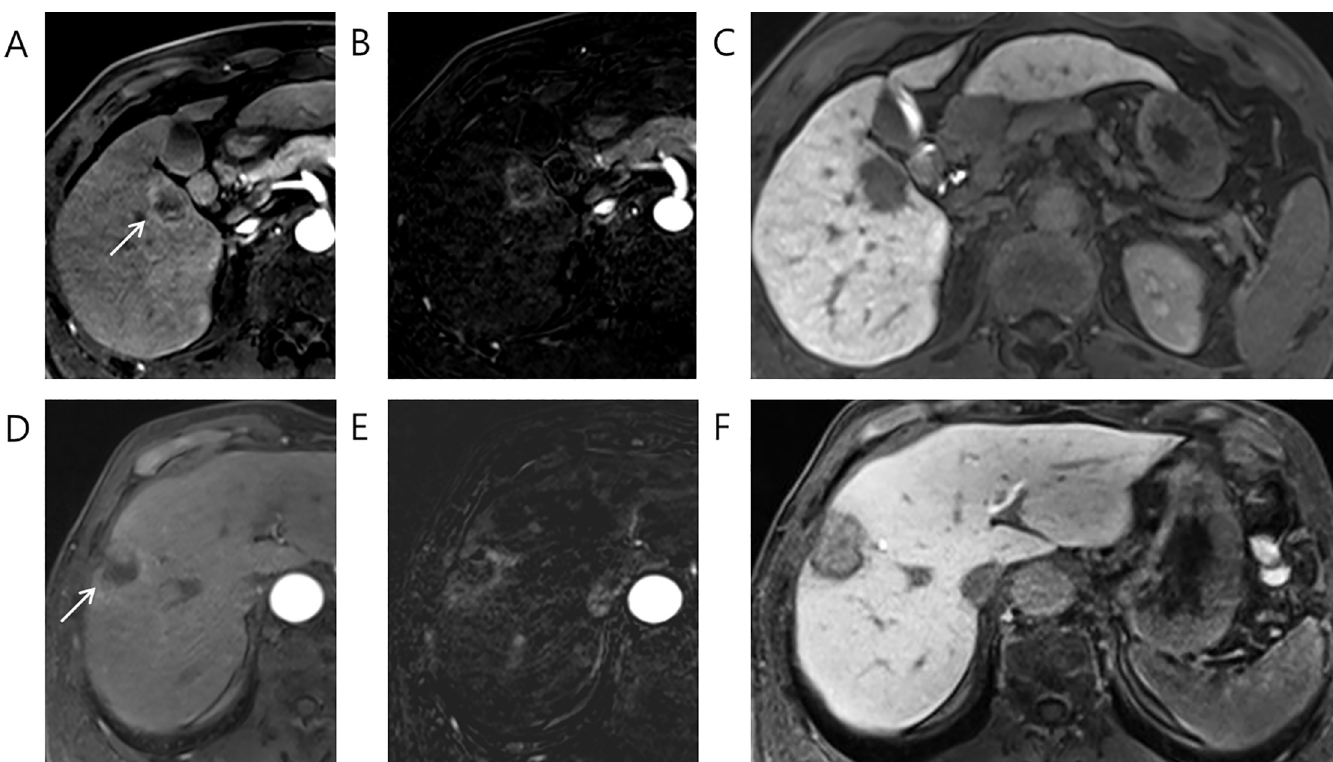
Fig 2. 46 year old male patient with Edmondson grade III HCC (A-C): rim APHE in (A) late arterial phase and (B) arterial subtraction image, (C) dark signal intensity in hepatobiliary phase. 74 year old male patient with intrahepatic mass-forming cholangiocarcinoma (D-F): rim APHE in (D) late arterial phase, and (E) arterial subtraction image, (F) low signal intensity in hepatobiliary phase.